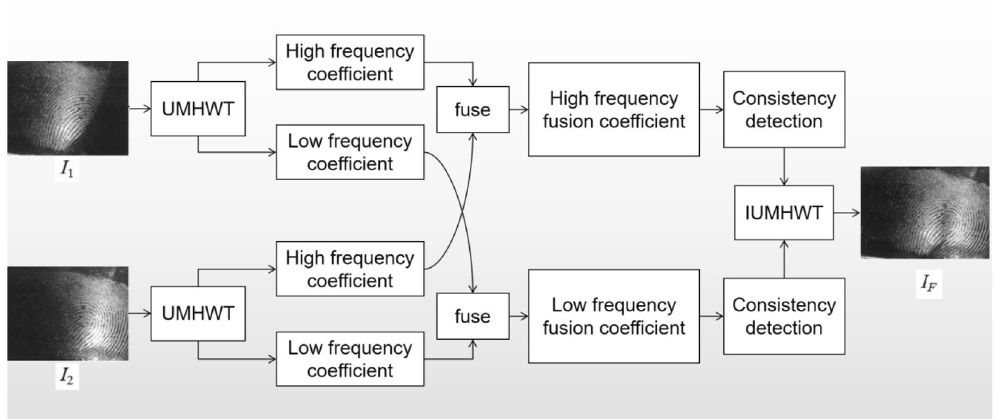
Figure 3. Flow chart of background image processing steps.